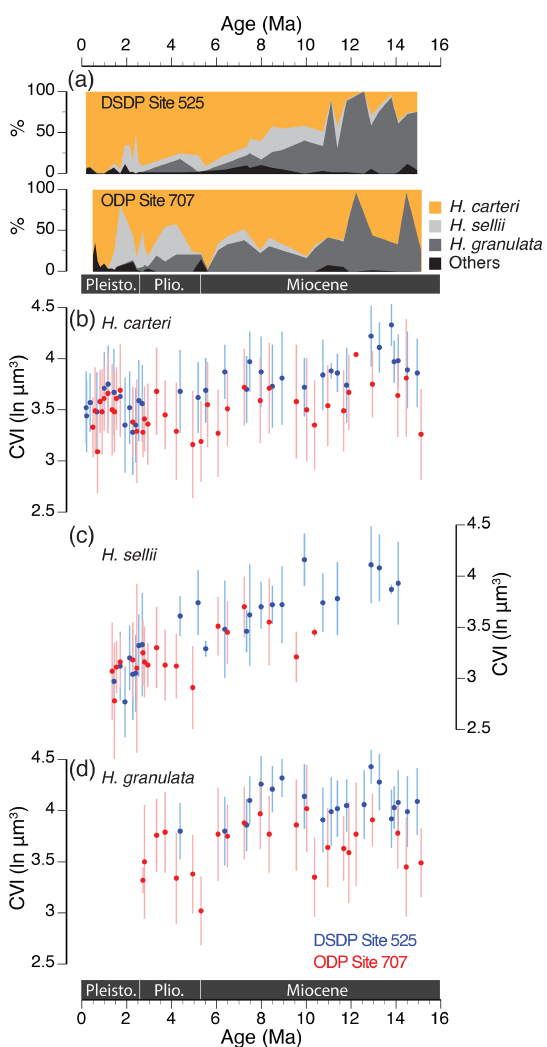
Figure 5. Phenotypic evolution of the most abundant Helicosphaera fossil morphospecies at DSDP Site 525 (in blue) and ODP Site 707 (in red) over the past 15Myr. (a) Relative proportions (%) of H. car- teri , H. sellii , H. granulata and other Helicosphaera morphospecies (closed sum). (b–d) Average CVI (lnµm 3 ) for each of the three most prominent morphospecies (names indicated in plots). The number of measurements per fossil data point is between 2 and 50 depending on the relative abundance of the species in a